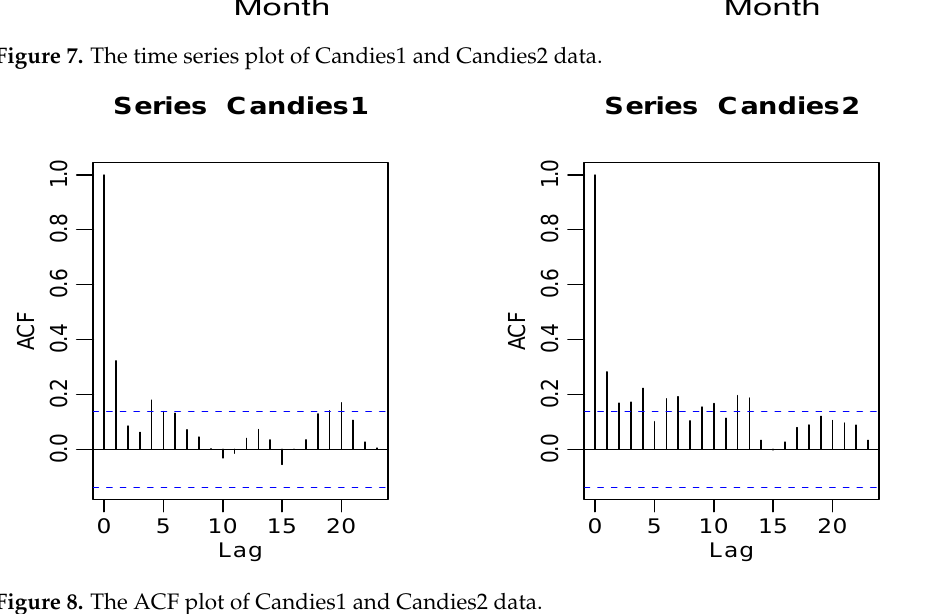
Figure 8. The ACF plot of Candies1 and Candies2 data.